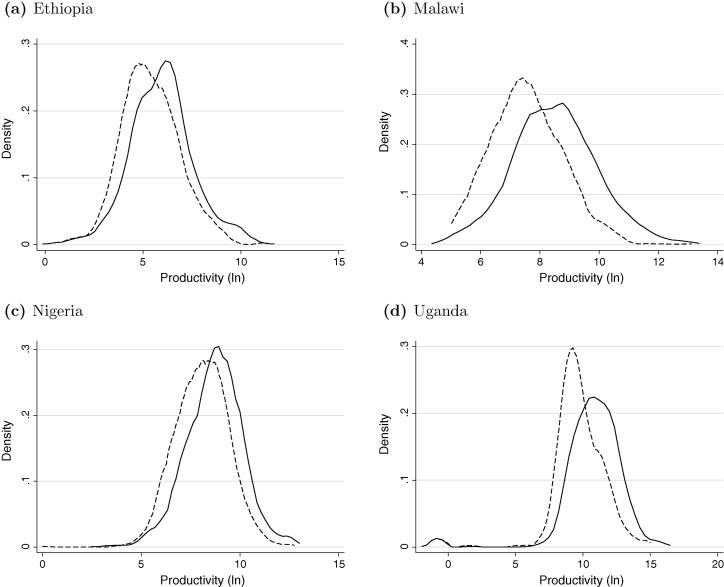
Productivity dispersal – by ability to read & write. Note(s): In (a)–(d) the continuous lines represent the productivity of enterprises where the enterprise owner has the ability to read & write and the dotted lines the productivity of enterprises with an illiterate enterprise owner. Authors’ own calculations based on LSMS-ISA data.